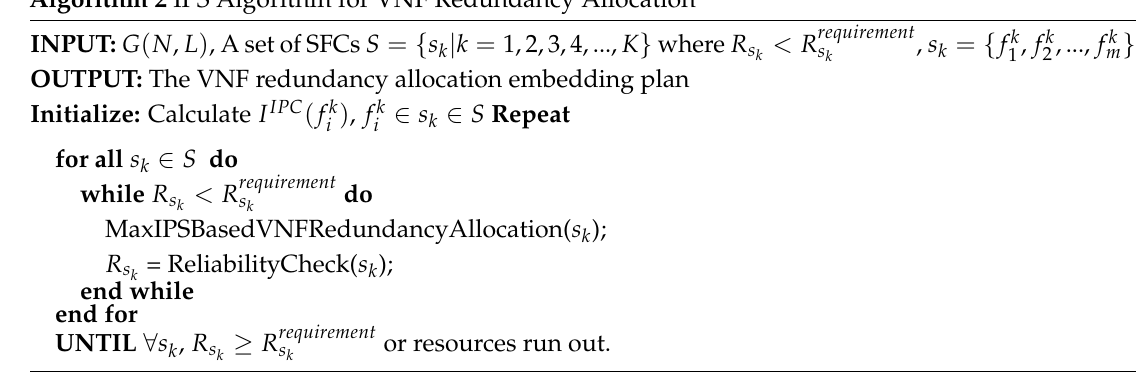
Algorithm 2 IPS Algorithm for VNF Redundancy